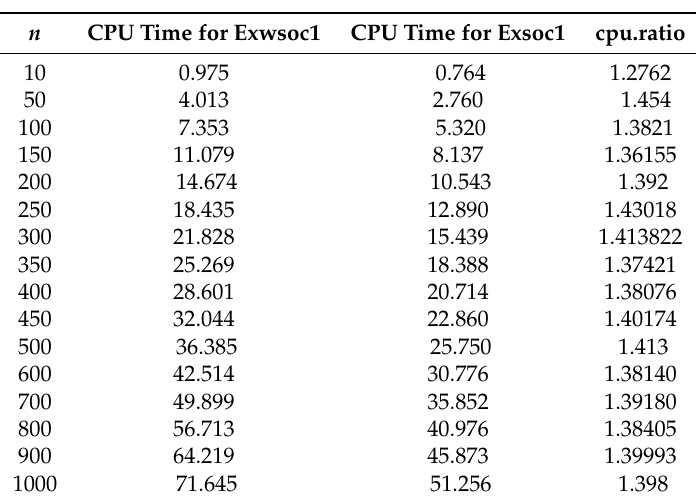
Table 3. CPU times corresponding to Example 1.